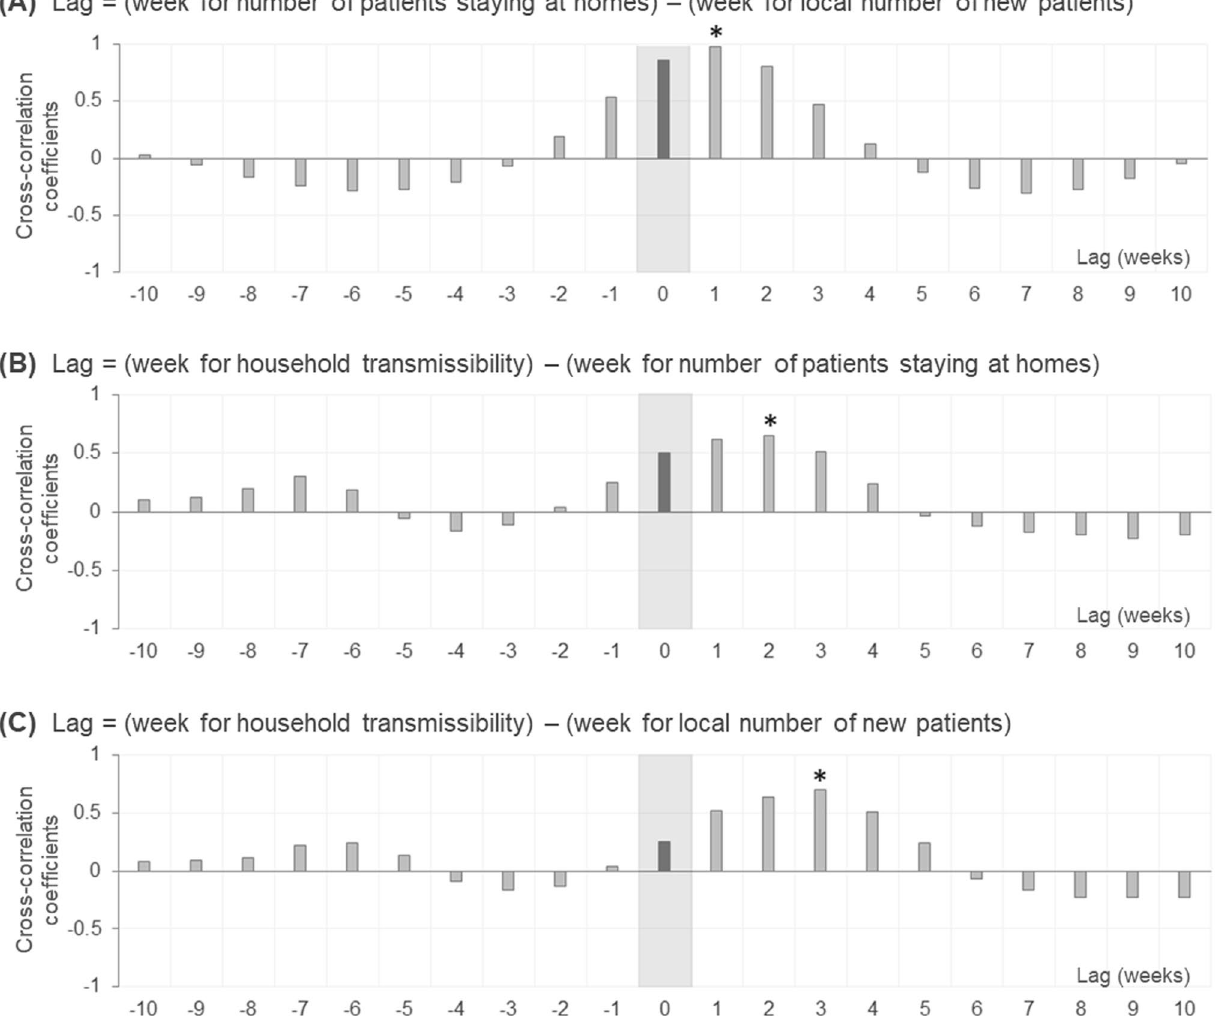
Figure 6. Cross-correlograms between local epidemics, number of patients staying at home, and household COVID-19 transmissibility. The local COVID-19 epidemic status is represented by the weekly number of newly diagnosed COVID-19 patients. The gray filled areas show the cross-correlations between two simultaneous variables with no time lag. The asterisk indicates the lag that produces the largest cross-correlation coefficient, suggesting a time delay between the two assessed